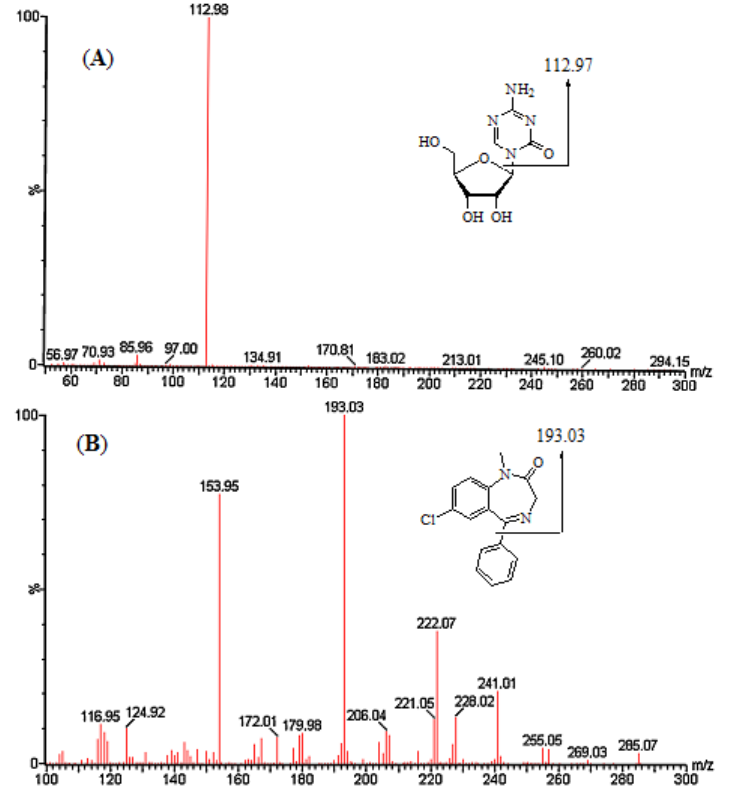
Figure 1. Product ion mass spectra of [M+H] + ions of azacitidine ( A ) and diazepam ( B